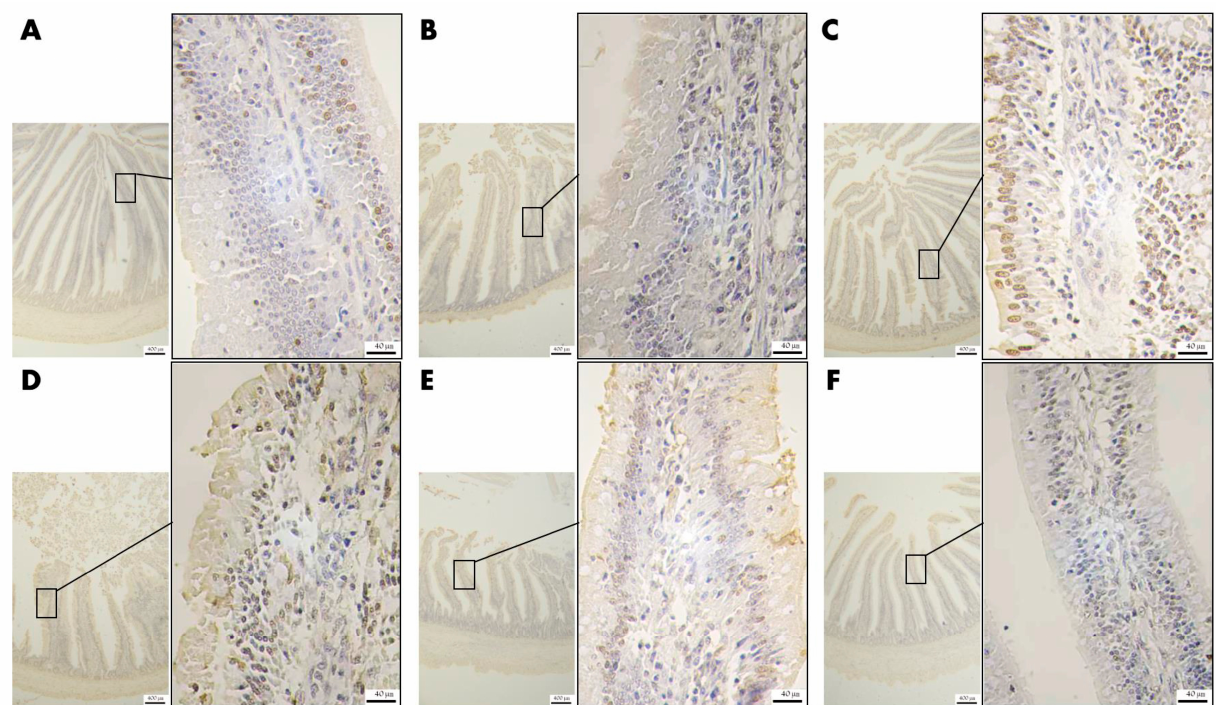
Figure 5. Effects of different levels of VD 3 supplementation on apoptosis of jejunal epithelial cells